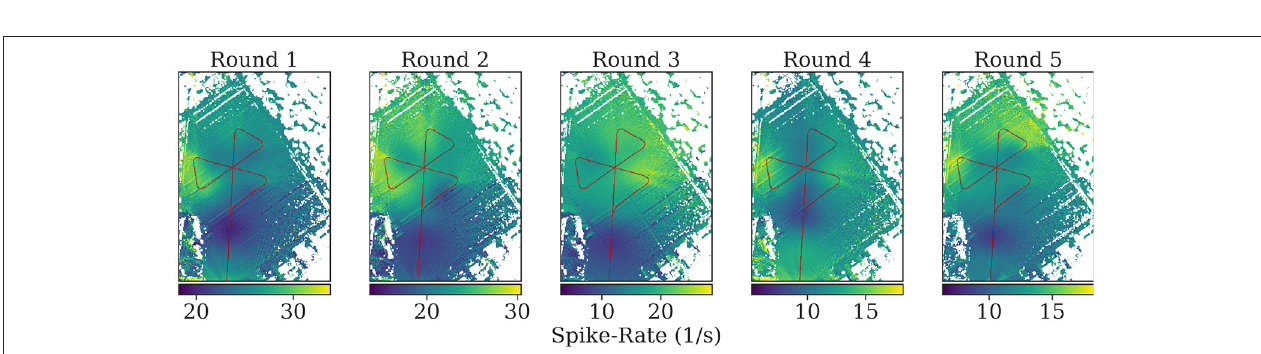
FIGURE 11 | Flight trajectories and spike rate. Each plot shows the spike rate as false color on top of the coordinates of the flown trajectory. The plots are in consecutive order for the first three flights of each bee [ (A) Bee A, (B) Bee B]. The following flights are depicted in the supplementary. At the center of the flower formation, the trained feeder is located. The spike rate in Bee B is more heterogeneous and higher at the corners. The flown corners in the experiments of bee B are sharper than for bee A.